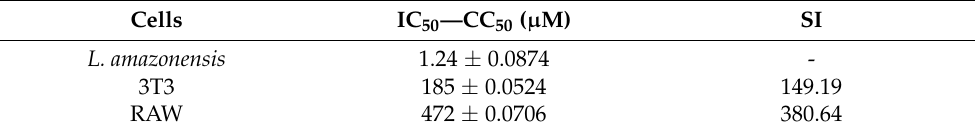
Table 3. Selectivity index values of the L1 compound for the parasite and mammalian cell lines.